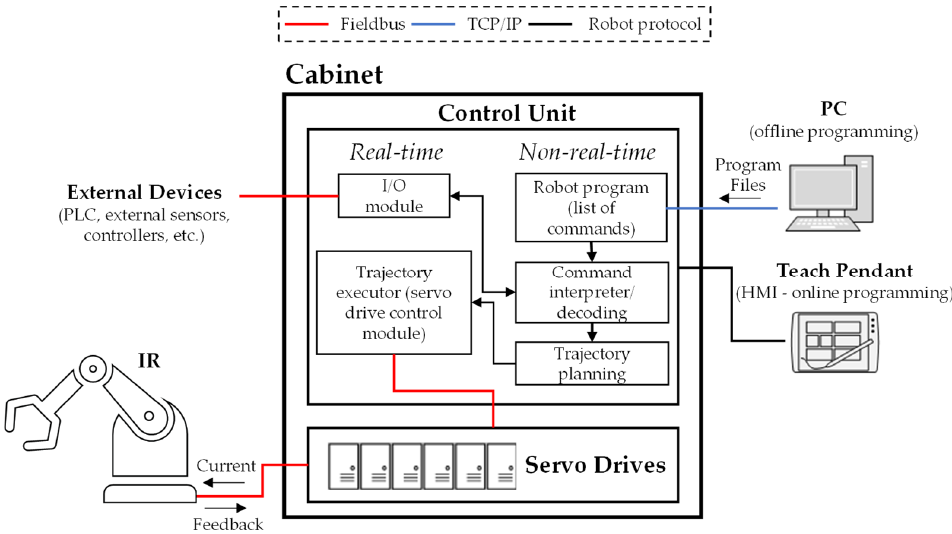
Figure 1. Traditional IR controller schematic.